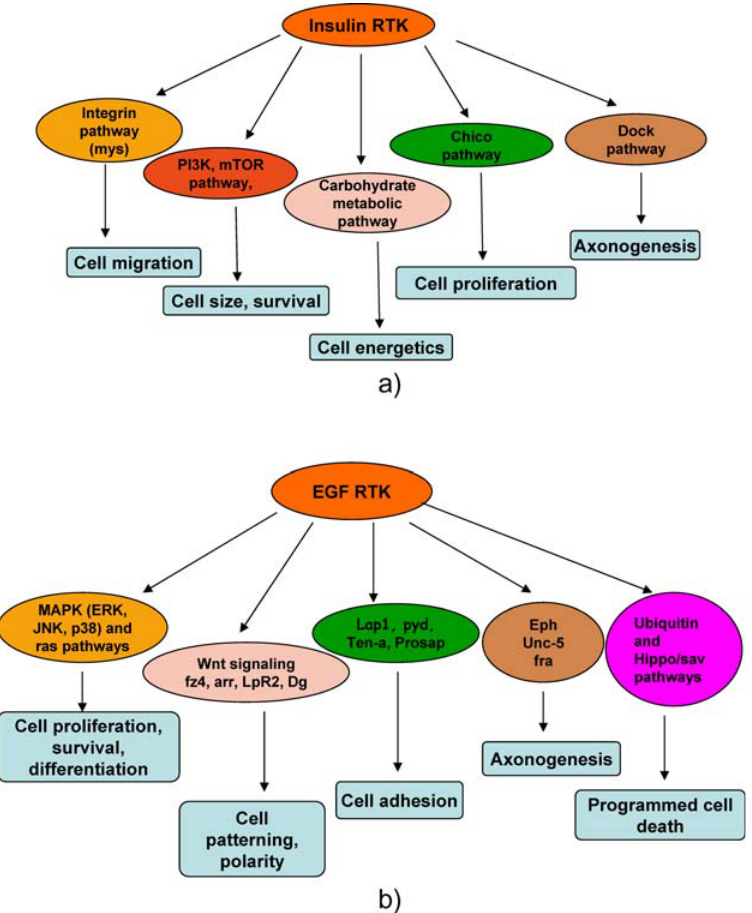
Figure 4. Tyrosine phosphorylation signaling pathways in Drosophila. a) Insulin RTK mediated tyrosine signaling pathways. b) EGF RTK mediated tyrosine phosphorylation signaling pathways.